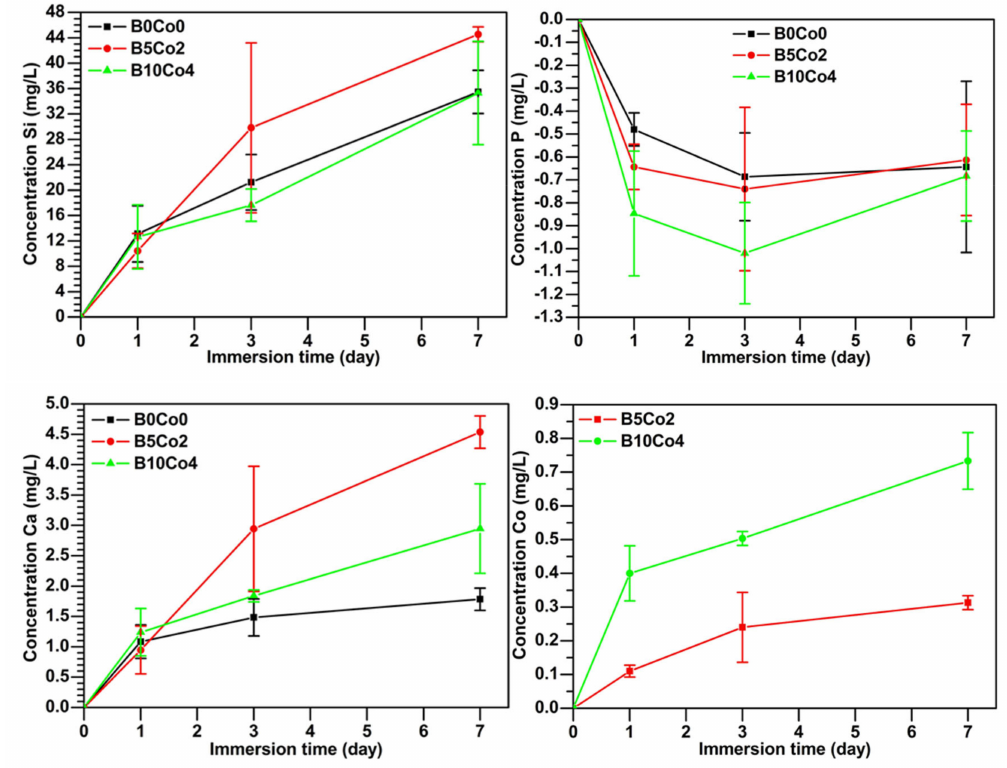
Figure 3. The cumulative ion (Si, P, Ca, Co) release concentration of BCo.BGNs after immersion in SBF for 7 days, measured with